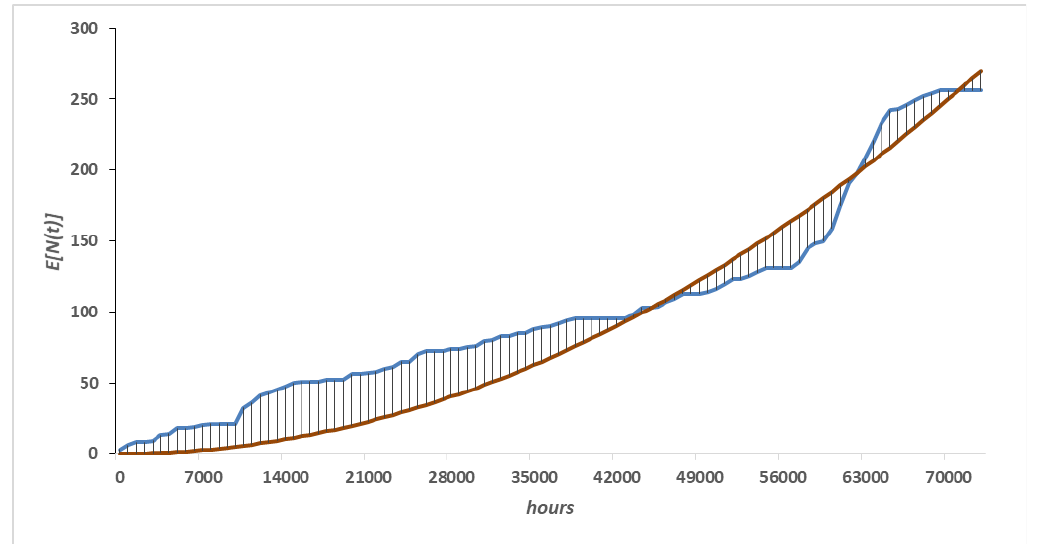
Figure 5. Square of x simple regression model of the escalator number